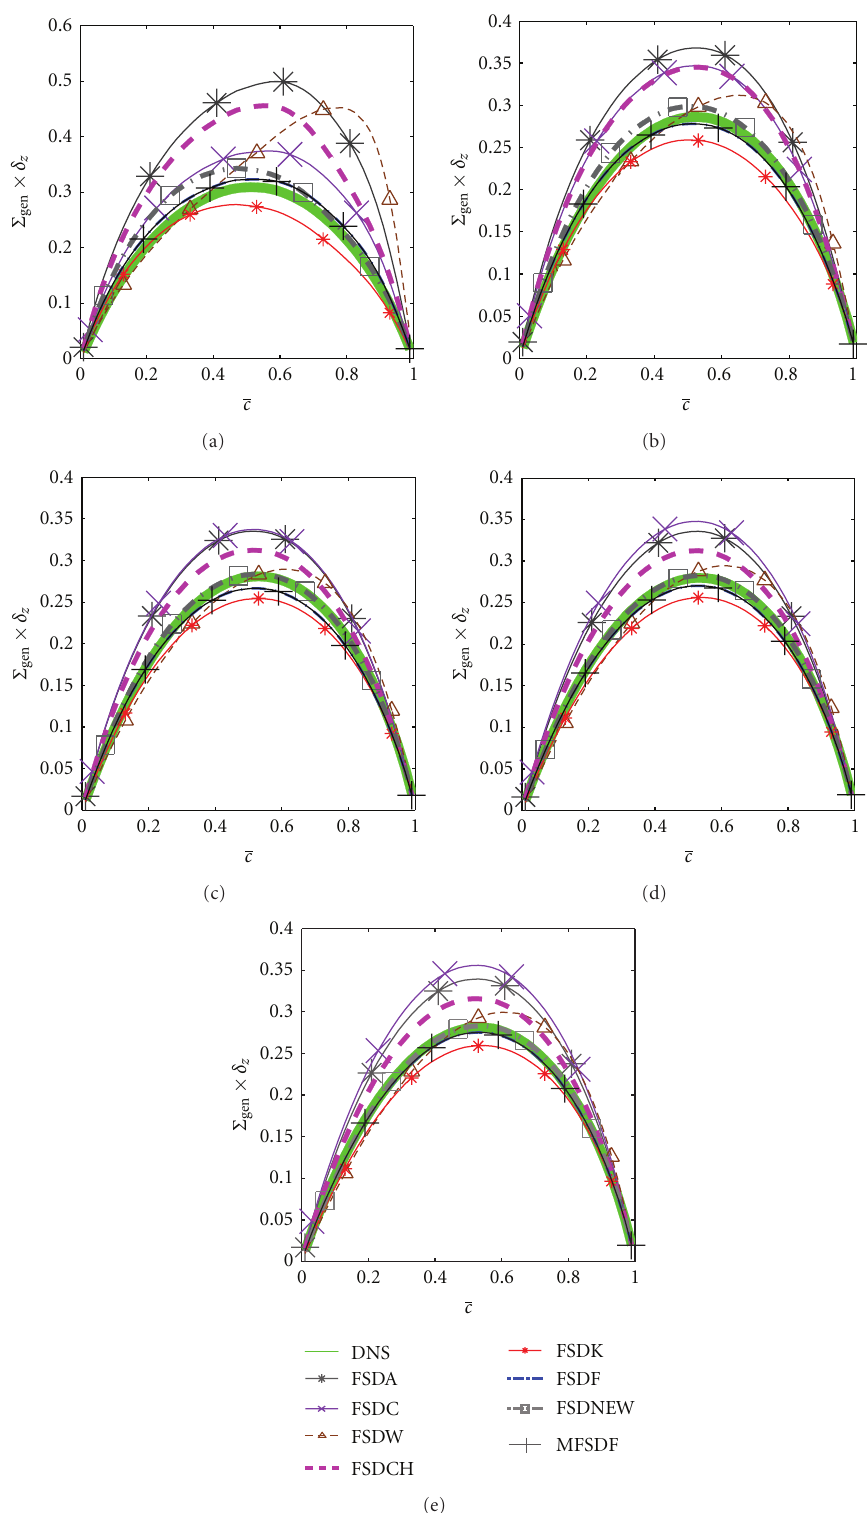
Figure 5: Variation of mean values of Σ gen × δ z conditional on c across the flame brush for Δ = 24 Δ m = 2 . 4 δ th according to DNS, FSDA, FSDC, FSDW, FSDCH, FSDK, FSDF, FSDNEW, and MFSDF predictions for (a–e) cases